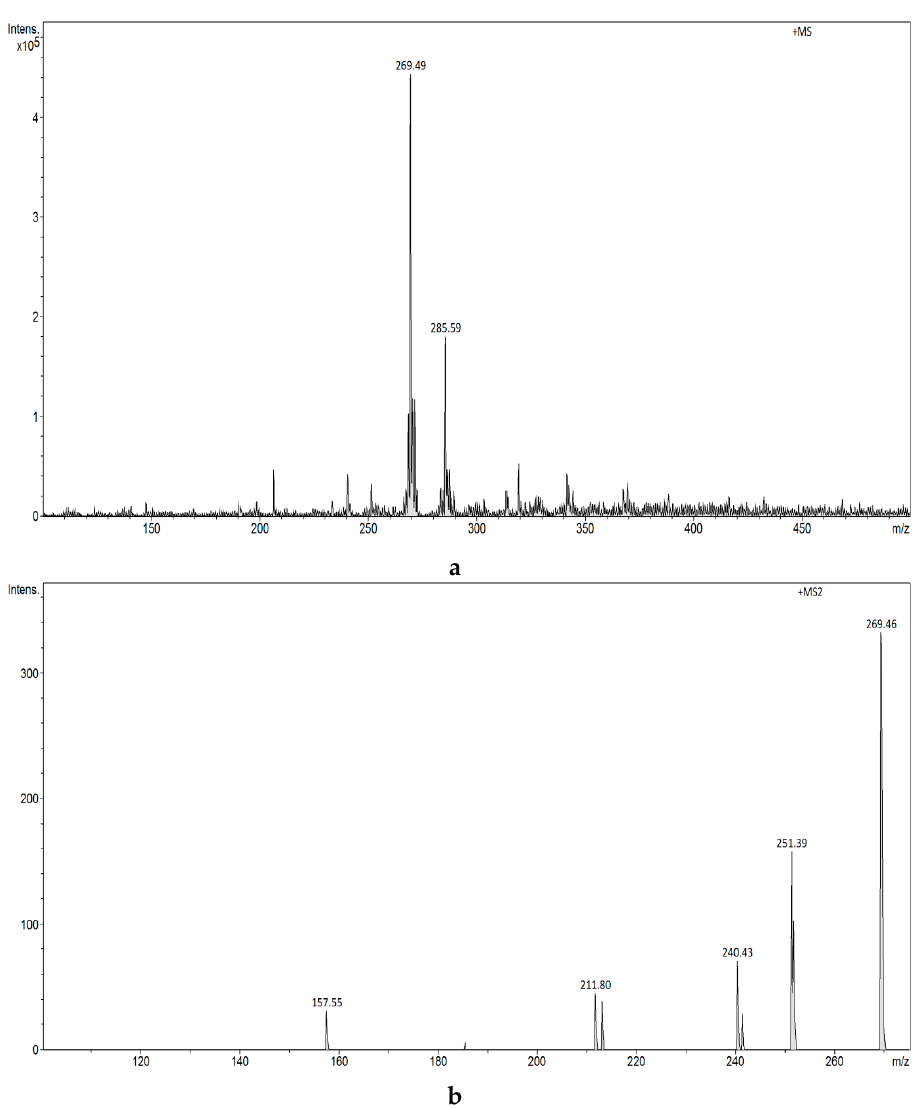
Figure 13. ( a ) FAPA-MS (positive ions) spectrum of E2 from E2-mag-MIP. ( b ) FAPA-MS 2 fragmentation spectrum of the m/z 269 ion observed for E2 from E2-mag-MIP.